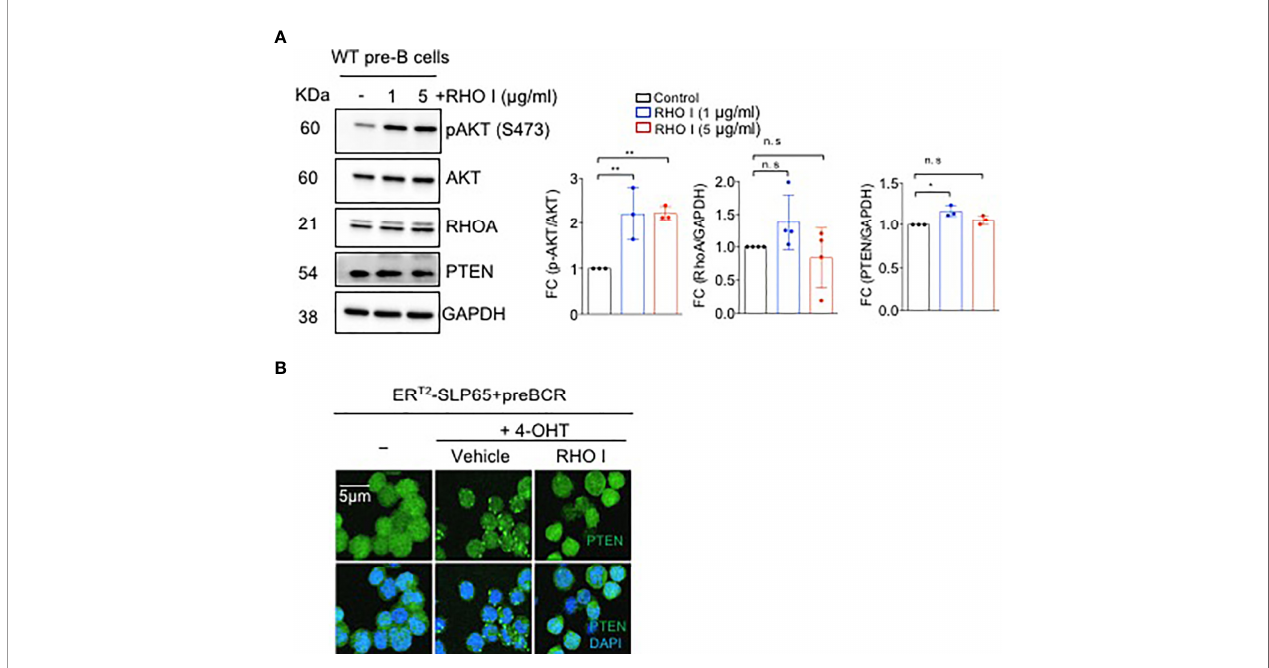
FIGURE 3 | SLP65 regulates PTEN localization through RHOA. (A) Left- Wildtype(WT)bone marrow derivedpre-B cells were treated with RHO-speci fi c inhibitorC3-toxin (RHO I) for 16 hoursor were leftuntreated for 16 hrs. Totalcelllysates were preparedand immunoblotting was performed.Data arerepresentative of 3 independent experiments. Right- quanti fi cation of the western blots. RhoA and PTEN blots are normalizedwith GAPDHwhilep-AKTisnormalizedwith totalAKT. Barsrepresent mean ± SD.Statisticaltest-one-way ANOVA with multiplecomparison test. (B) SLP65 de fi cient pre-B cells were retrovirallyreconstituted with ERT2-SLP65 and were induced with 4-OHT for 30 min with orwithout RHO (I) Cells treatedwith vehiclewere used as a control.Cellswere then fi xed with 2% paraformaldehydeand labeled with DyLight 488 conjugated anti-PTEN antibody andDAPI staining for immuno fl uorescent microscopy. Images were captured by usinga Zeiss LSM 780 laser scanning confocal microscope with GaAsP detectorsand visualized with Imaris software. *p<0.05, **p<0.01, ns, not signi fi